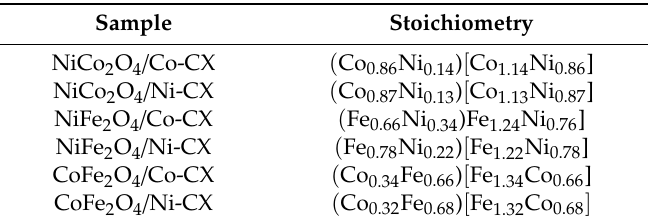
Table 5. Samples stoichiometries obtained from XPS.